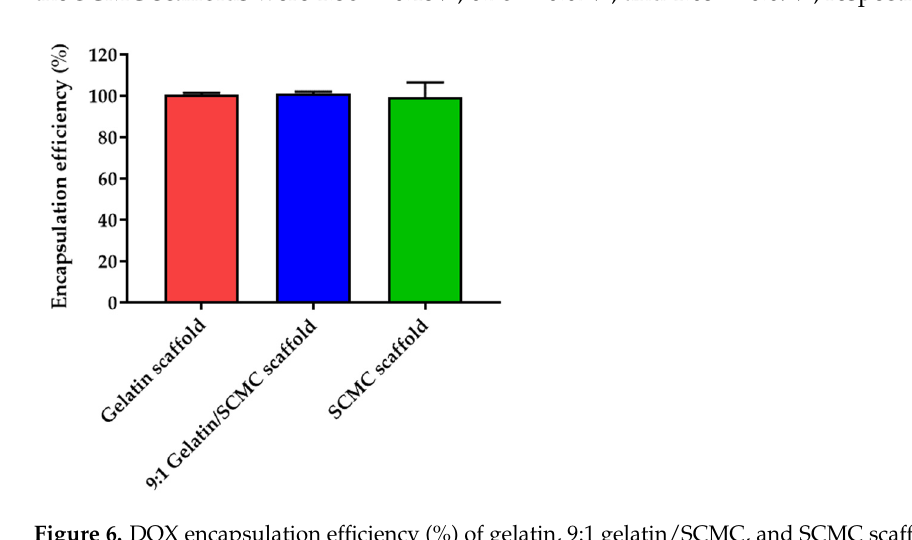
are expressed as mean ± Figure 6. DOX encapsulation efficiency (%) of gelatin, 9:1 gelatin/SCMC, and SCMC scaffolds. Data